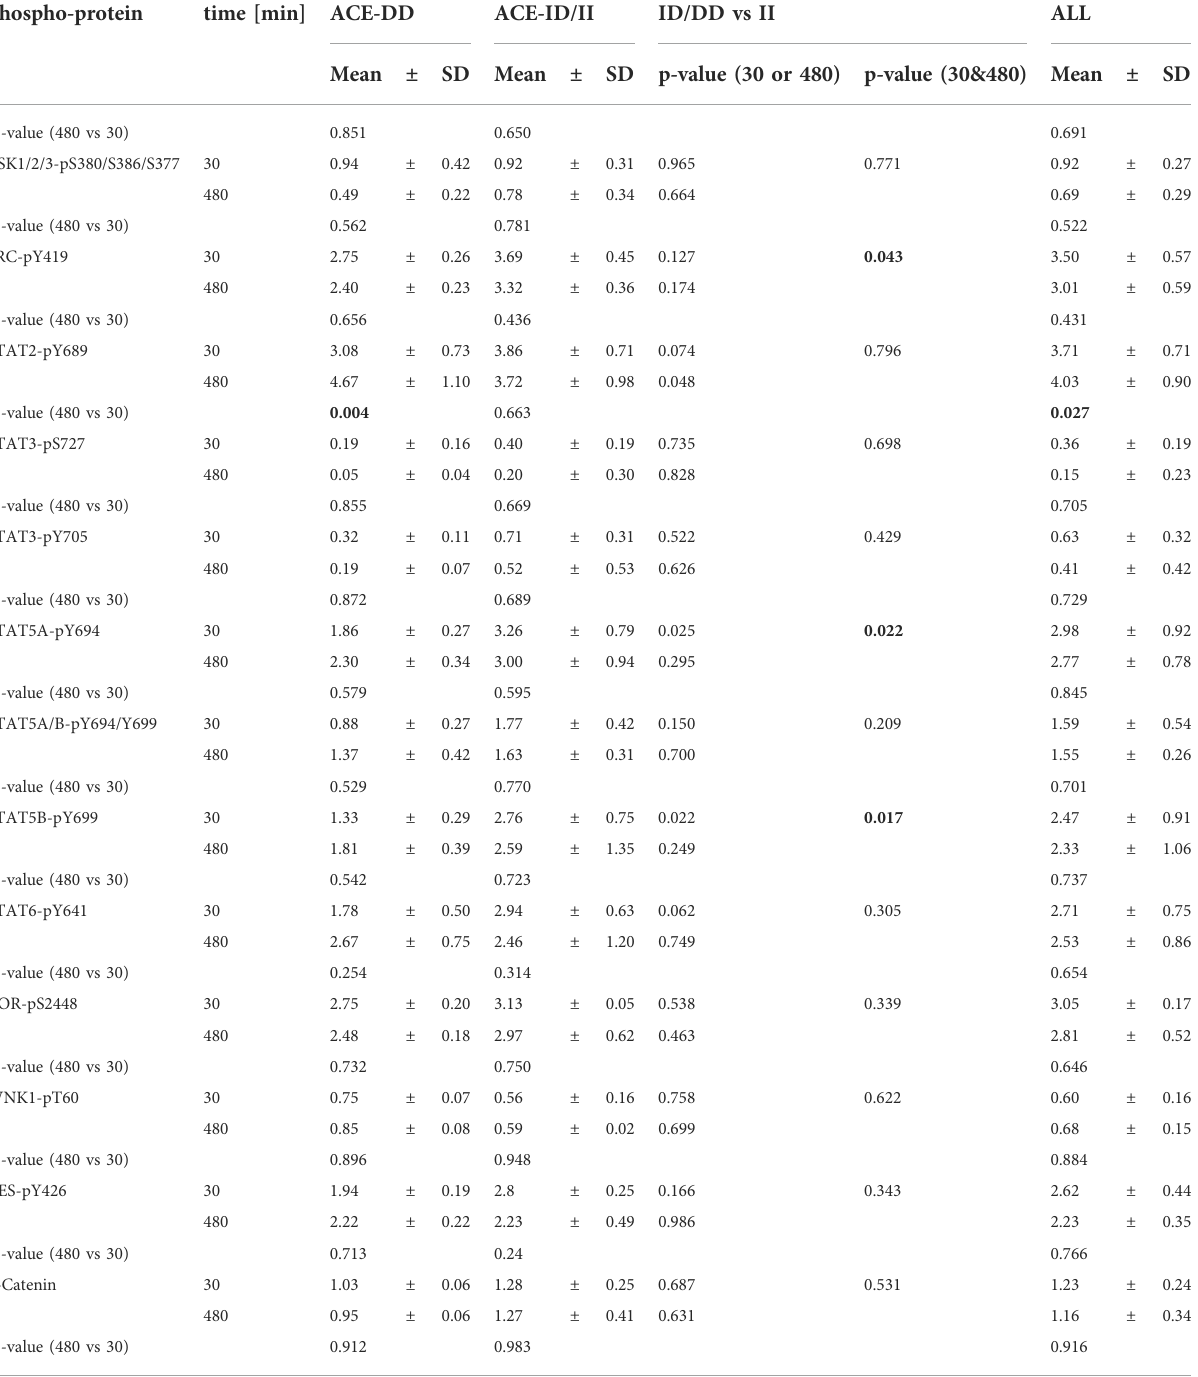
Mean±SDforthereferencerelatedvaluesofassessed45phospho-proteins(asrelatedtothesignalsofthereferencespots×100),andtherespectivep-valuesforthepost/hoceffectsoftimeand ACEI-allele(i.e.,genotype).Boldvaluesindicateeffectswhichweredeemedsigni fi cantatp < 0.05.Phospho-proteinsinbolddemonstratedgenotypeeffects.ANOVAwithpost/hoctestofleast signi fi cant